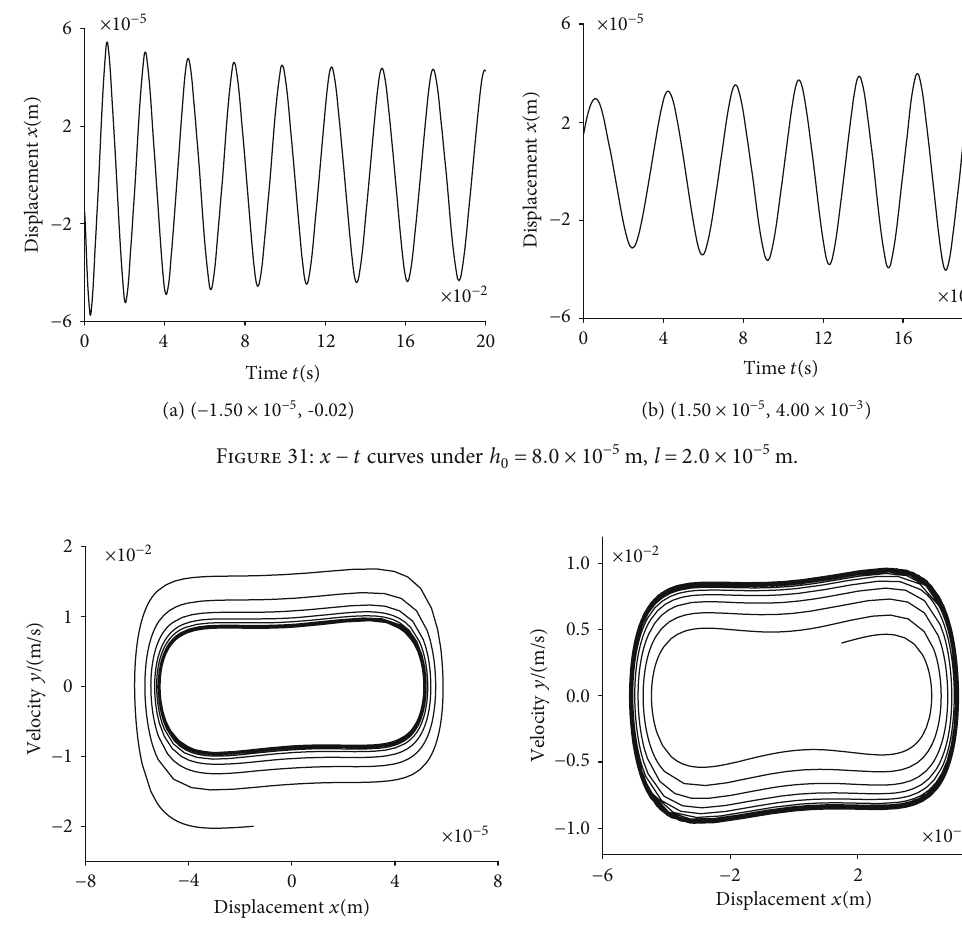
Figure 32: Phase trajectories under h